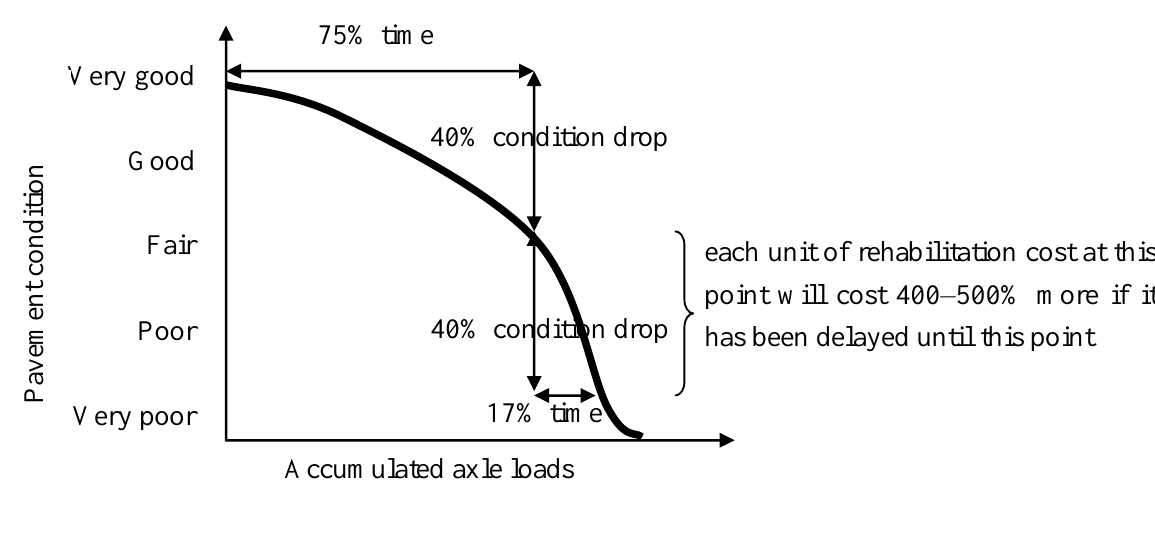
Figure 1. Rehabilitation time versus cost (adapted from